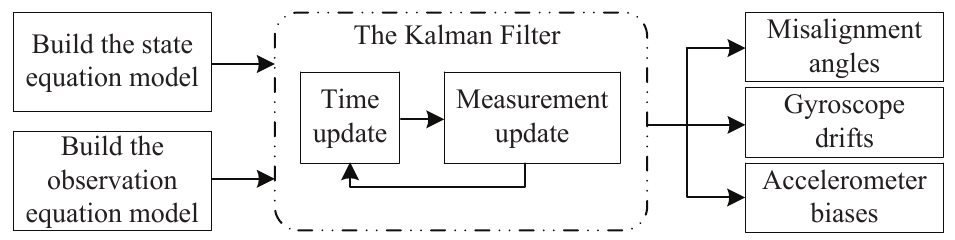
Figure 2. The block diagram of the Kalman